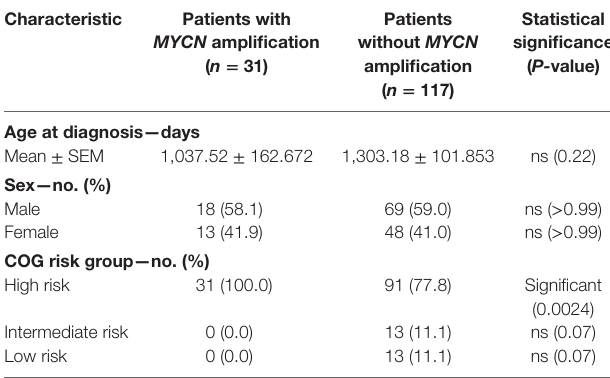
Table 1 | Baseline characteristics of the